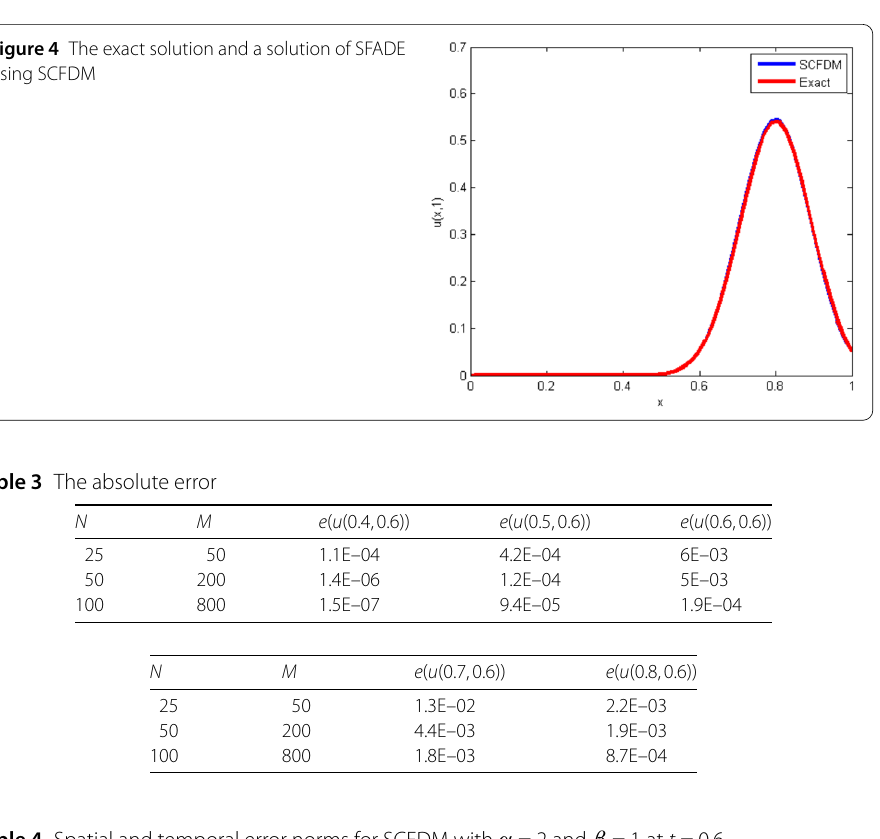
Table 4 Spatial and temporal error norms for SCFDM with α = 2 and β = 1 at t =